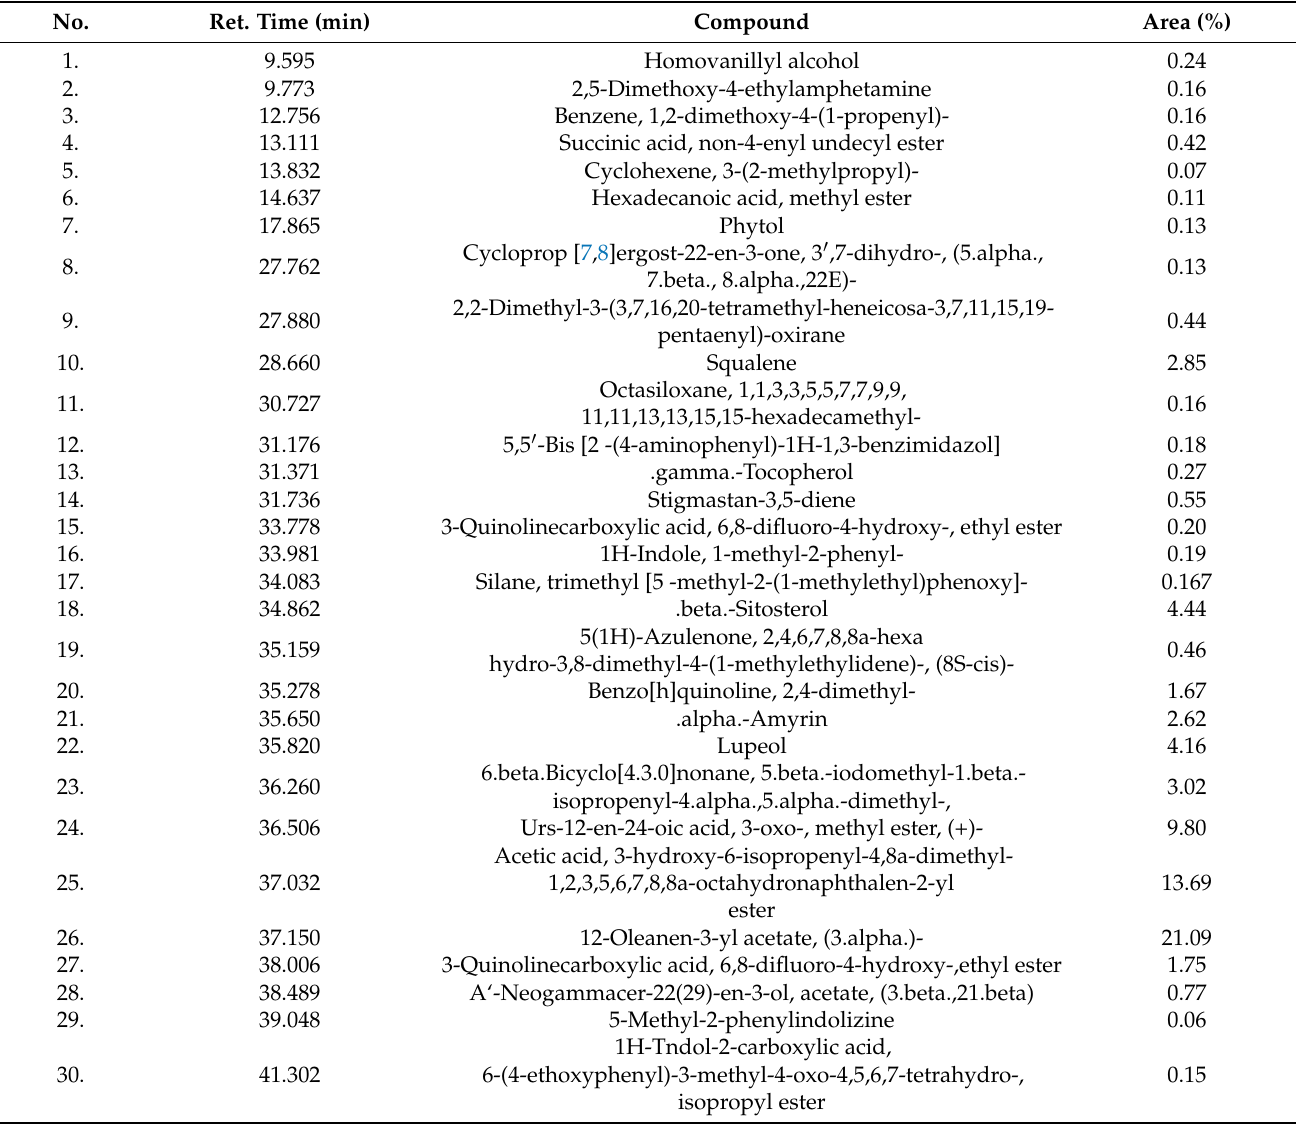
Table 2. Phytochemical contents of F. lepicarpa identified using